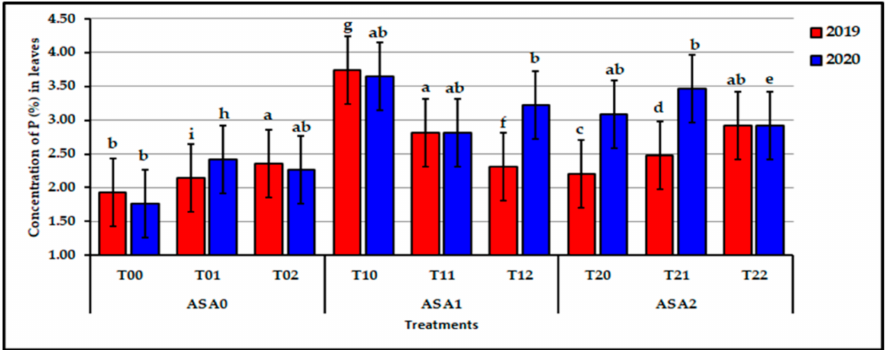
Figure 2. Influence of interaction between zinc oxide nanoparticles and ascorbic acid on leaf P content of stressed sweet potato plants in 2019 and 2020 seasons. Bars with a different letter indicate significant difference between treatments at p ≤ 0.05.